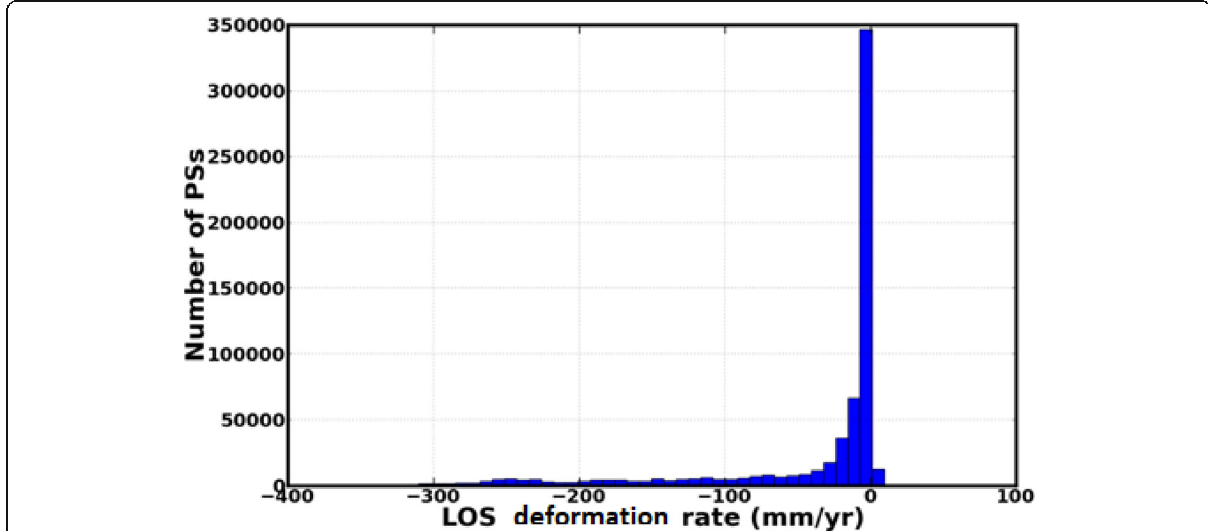
Fig. 9 Histogram of PSI ’ s deformation rates for Mexico City study area